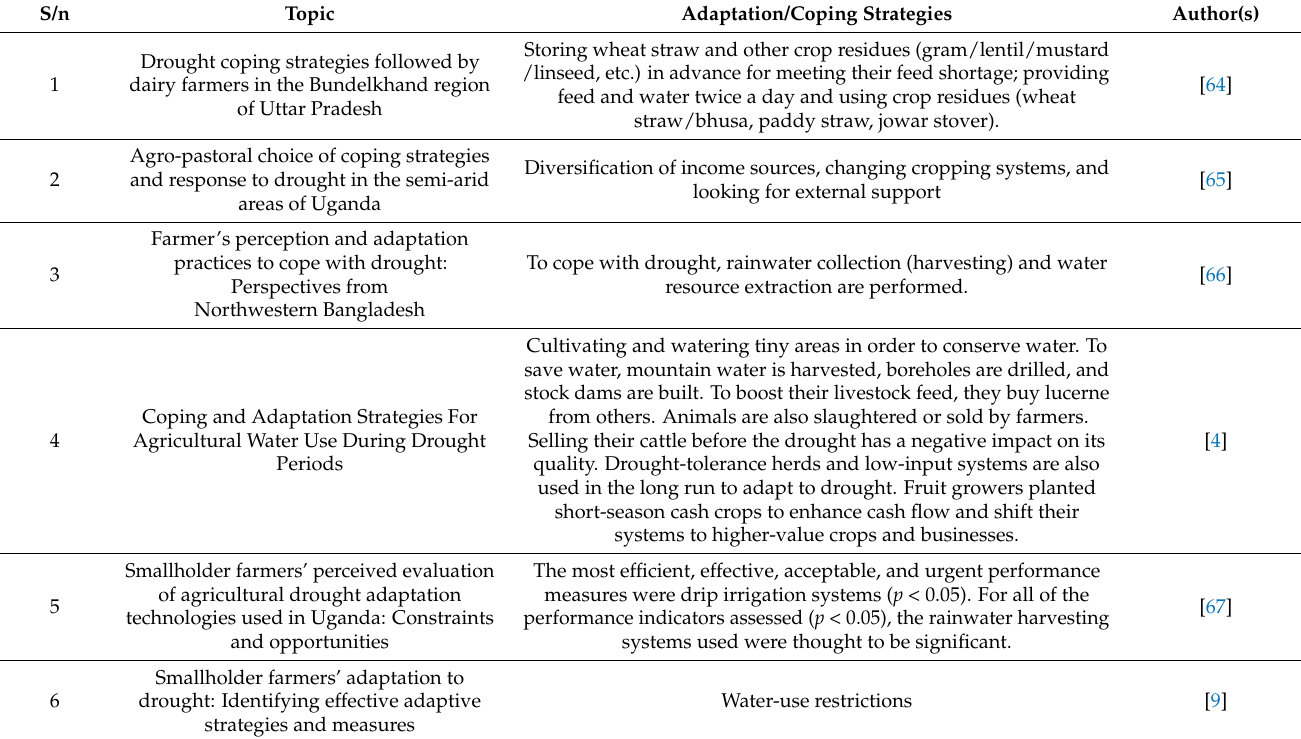
Table 7. List of adaptation/coping mechanisms used by farmers to mitigate